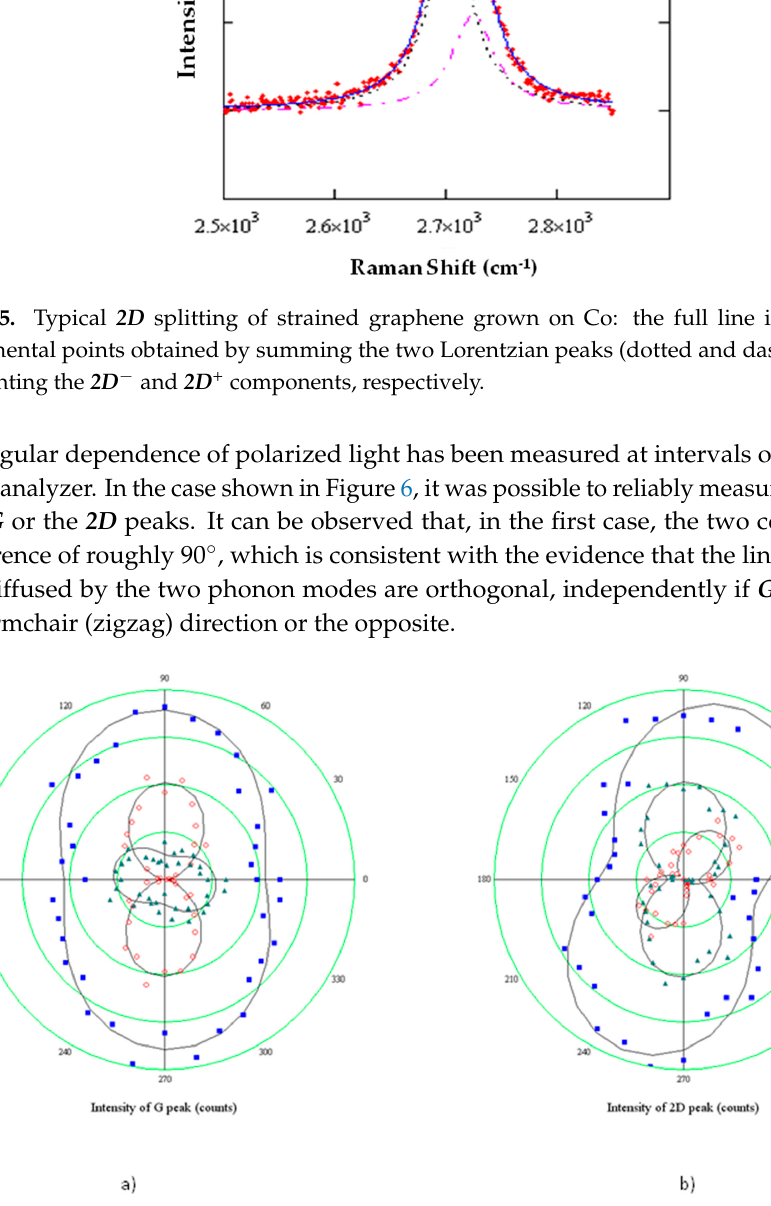
Figure 6. Angular dependence of components of the split peaks in strained graphene grown on Co: ( a ) polar plot of the integrated intensity of the Raman emission of graphene at ~1590 cm − 1 ( G mode) as a function of the angle between the direction of polarization of the incident beam and the analyzer; circlets refer to G − , triangles to the G + , dots to the total intensity, lines are sinusoidal fits; ( b ) The same as in ( a ), but for the 2D peak. The orientation of the sample is the same for both graphs, with the minor axis of the elliptical hole oriented parallel to the polarization direction of the laser beam.